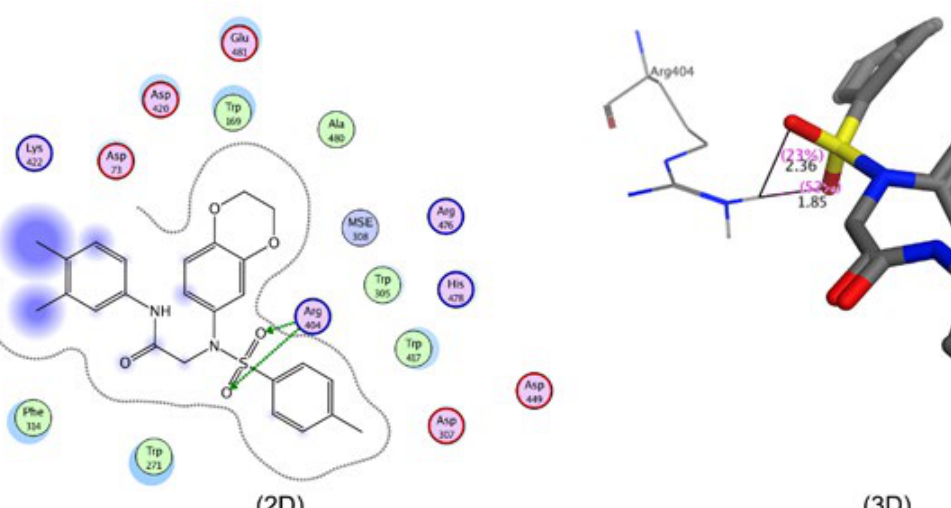
FIGURE 2 - Molecular docking of 7g against yeast α-glucosidase.